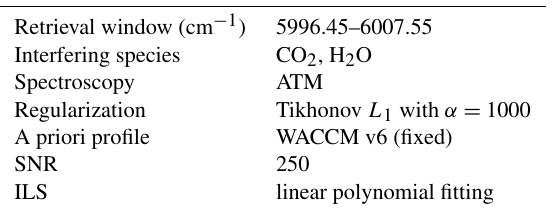
Table 2. Lists of the most important parameters in the SFIT4NIR retrieval strategy.